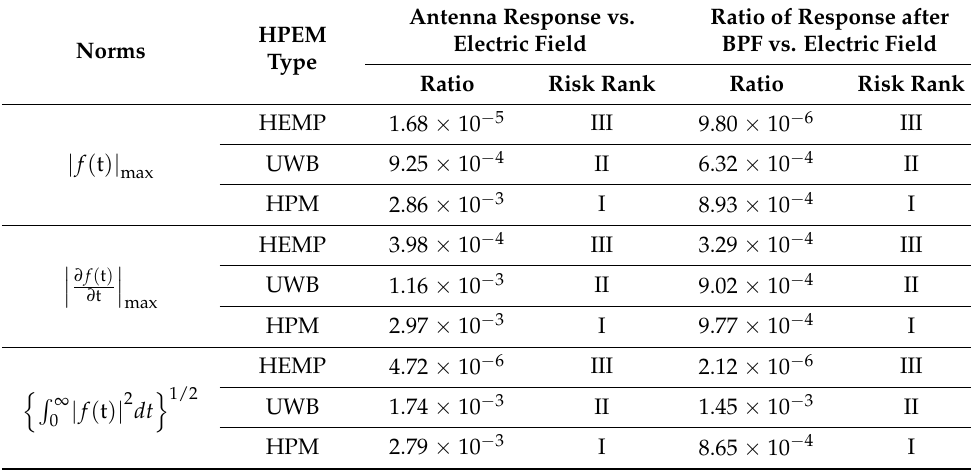
Table 3. Risk rank results of the HPEMs for the linear RF